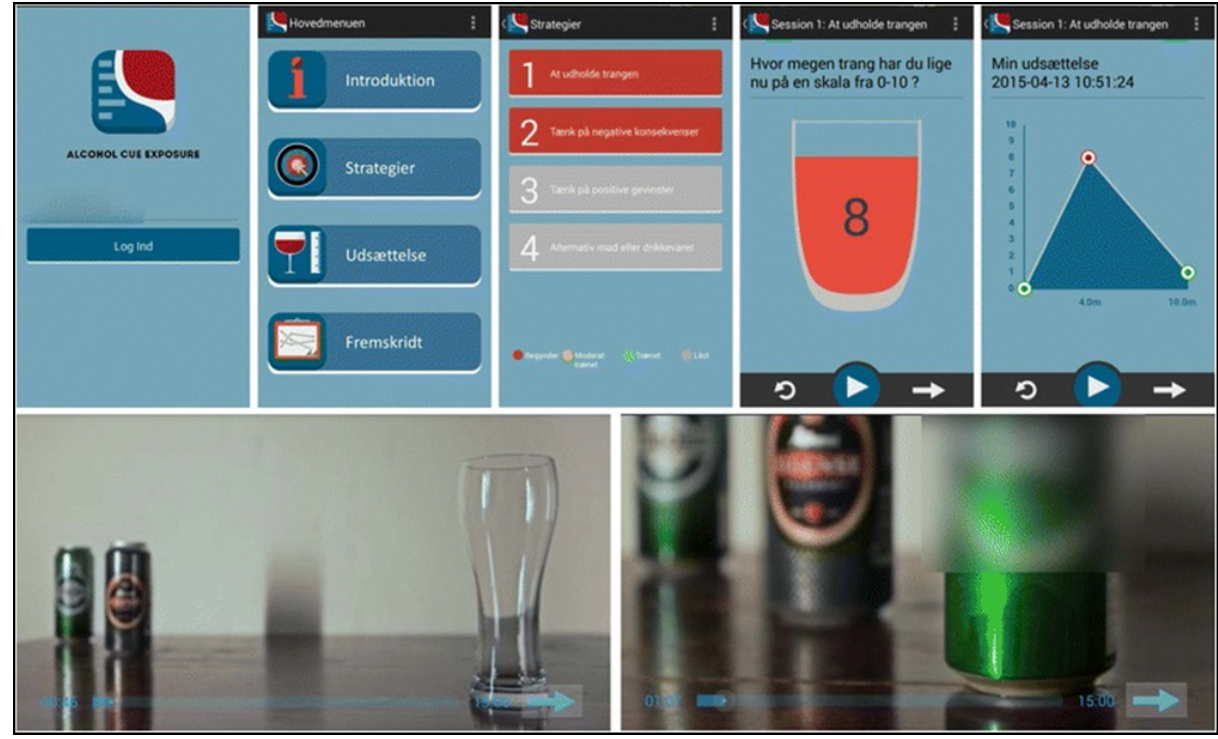
Figure 1. Illustration of the mobile phone app for cue exposure